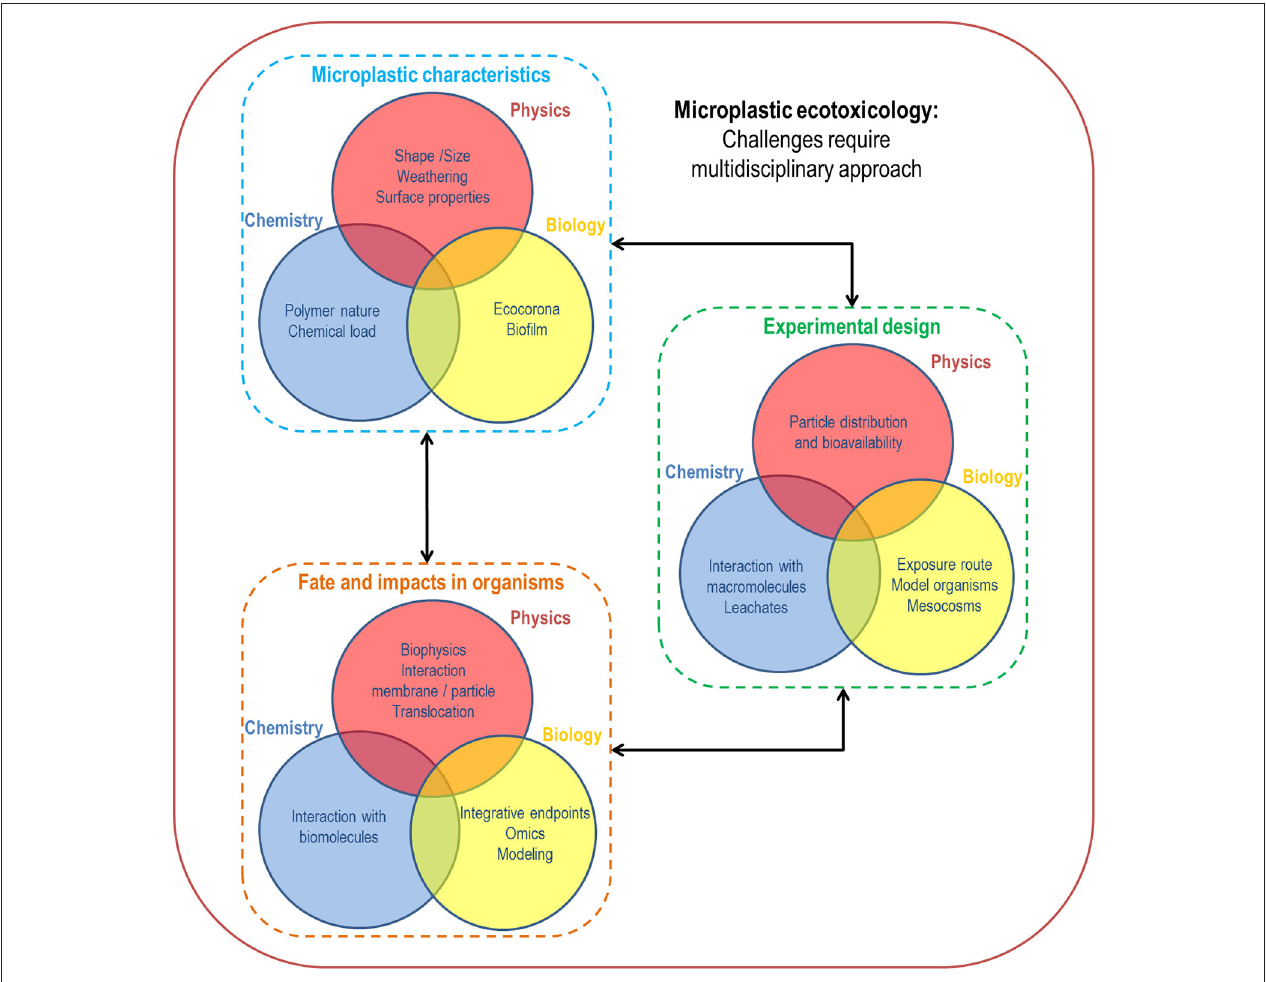
FIGURE 7 | Main challenges in microplastic ecotoxicology requiring multidisciplinary approaches including physics, chemistry and